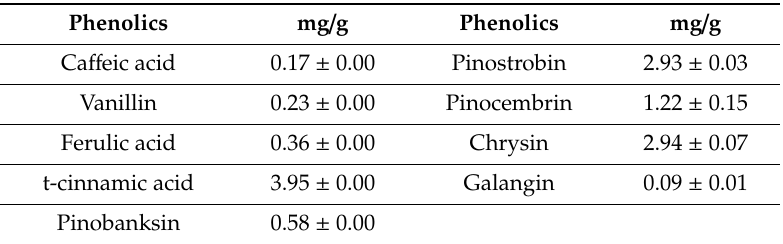
Table 6. Major individual phenolic substances and quantities defined in propolis for three parallel (Mean ±